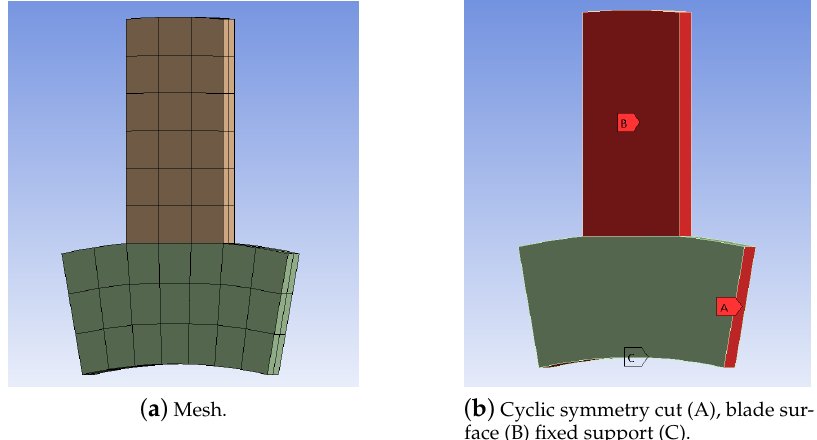
Figure 2. Dummy test case with cyclic